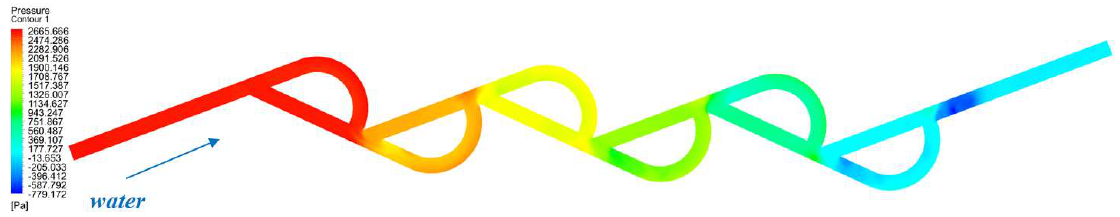
Figure 14. Cloud diagram of pressure distribution .